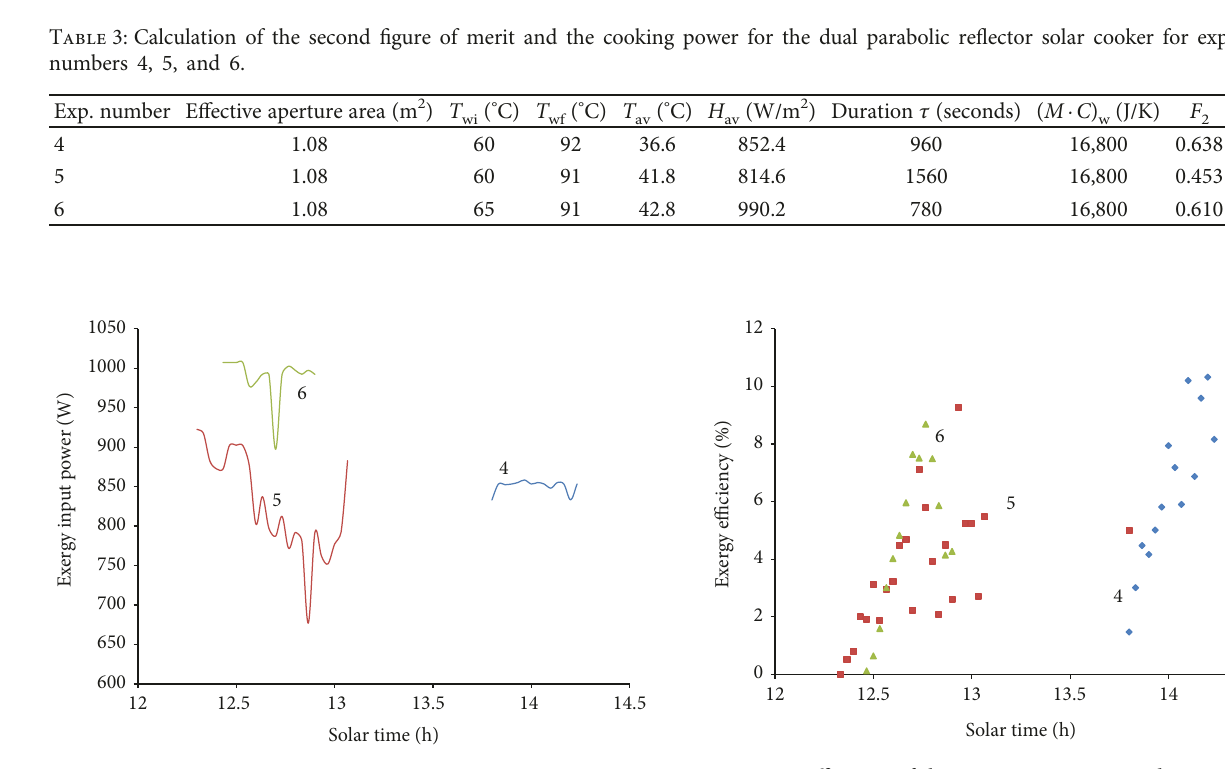
Figure 17: Exergy input power during the three experiments with 4 kg of water load. Curves are labeled according to the experiment number.